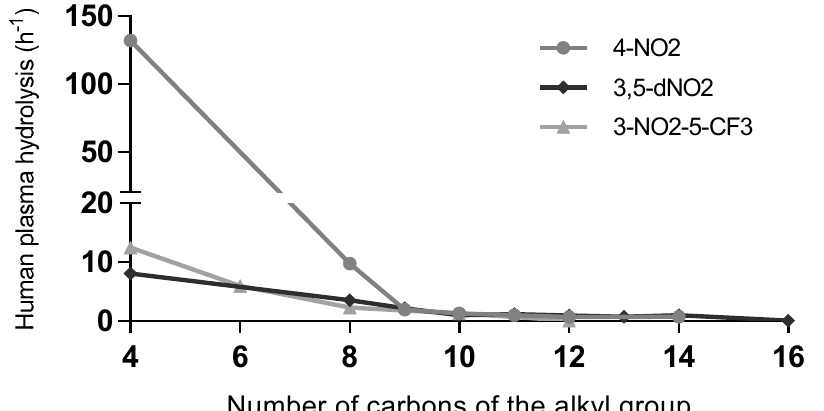
Figure 4. Stability in plasma of derivatives with nitro groups in the aromatic ring as a function of the chain lengths. Aromatic substituents: 4-nitro (4-NO 2 ), 3,5-dinitro (3,5-dNO 2 ), and 3-nitro-5- (trifluoromethyl) (3-NO 2 -5-CF 3 ).